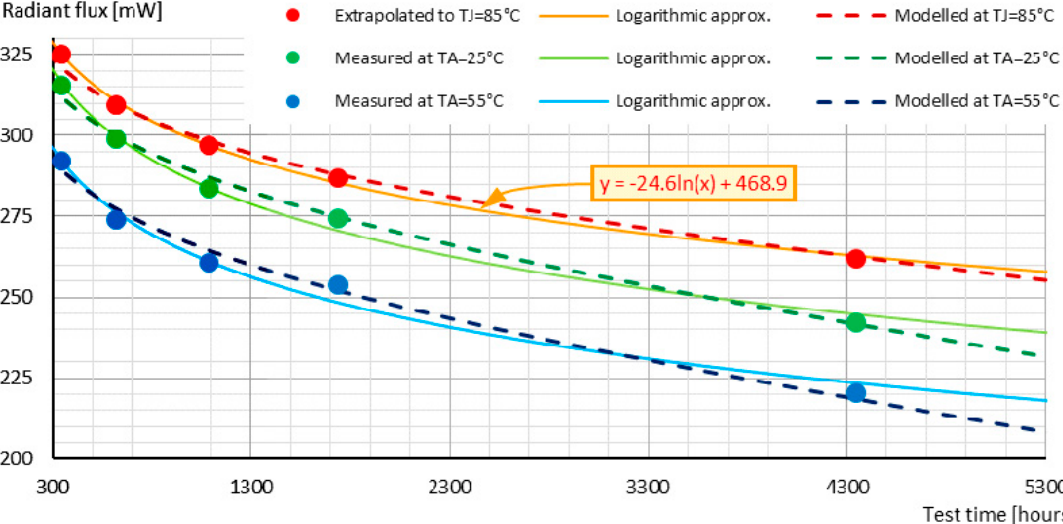
Figure 6. Measurement and simulation results of the aged mid-power blue LED; the logarithmic regression fitting parameters to the 85 °C values are indicated just as an example.